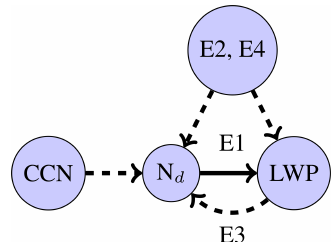
Figure 1. A simplified picture of the N d –LWP system, showing factors impacting the causal relationship (“E1”) – potential mete- orological confounders and retrieval errors (“E2”, “E4”), LWP de- pendent controls on N d (“E3”) and the impact of aerosols on N d